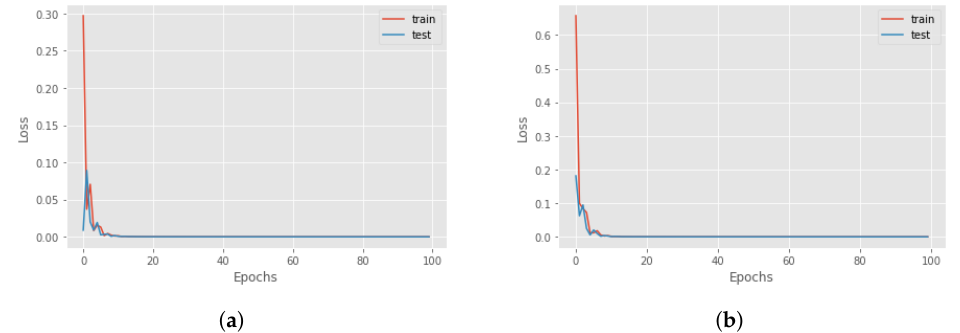
Figure 12. Results of the training and test of the RNNs for the distal prediction in the Cartpole en- vironment. ( a ) Loss of the RNN for the distal direct prediction. ( b ) Loss of the RNN for the distal counterfactual